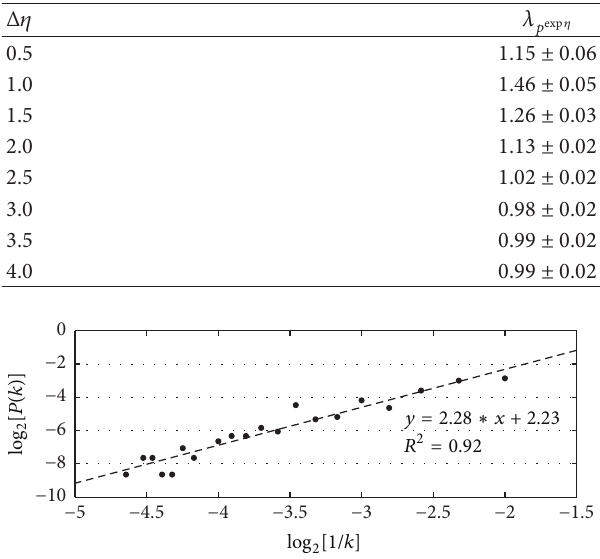
Table 2: Values of 𝜆 𝑝 calculated for multipion production in 32 S- Ag/Br interactions, 𝜂 -range wise around the central rapidity regions.